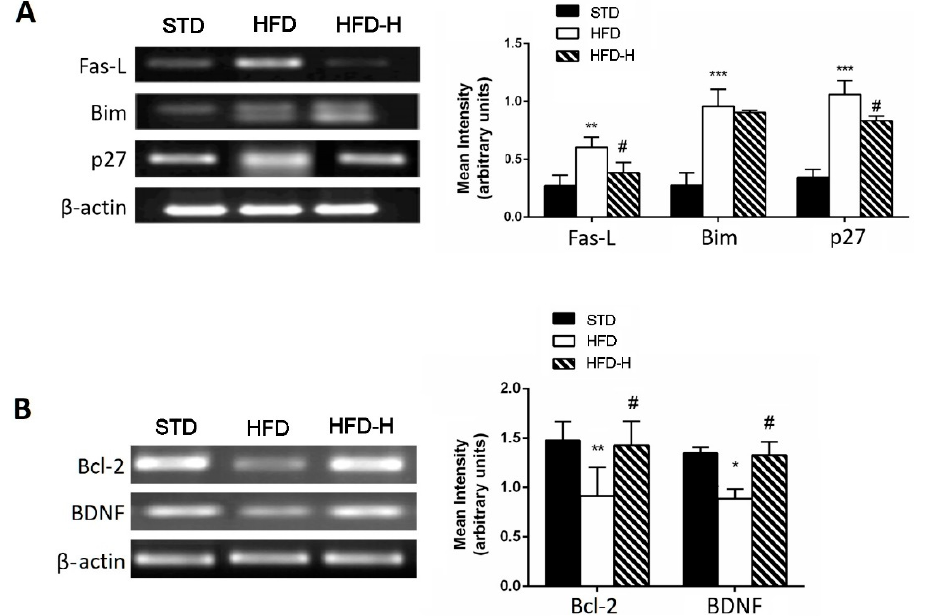
Figure 4. Effects of long-term honey ingestion on apoptosis-related gene expression in HFD mice. Honey downregulated pro-apoptotic gene expression and upregulated anti-apoptotic genes. ( A ) Representative images of the RT-PCR results and mRNA levels of pro-apoptotic genes: Fas-L, Bim and p27; ( B ) RT-PCR results and mRNA levels of survival genes: Bcl-2 and BDNF. Data are mean values ± S.E.M. ( n = 8/group). * p < 0.05, ** p < 0.01, *** p < 0.001 vs. STD mice; # p < 0.05 vs. HFD. STD: